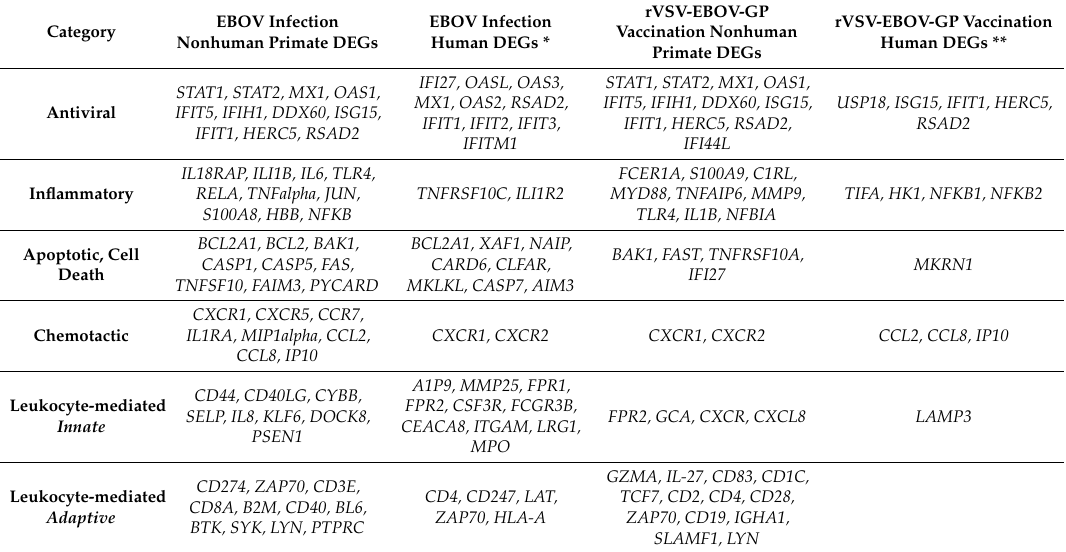
Figure 1. Host response to EBOV infection and rVSV-EBOV-GP vaccination. ( A ) EBOV infection induces a strong, sustained secretion of cytokines and interferon by myeloid cells. Impaired activation of APCs coupled with apoptosis induced by pro inflammatory mediators cumulates in lymphocyte death, preventing the host from mounting an e ff ective adaptive immune response. excessive inflammation, coagulopathy and di ff use organ failure precedes death of the host. ( B ) In contrast, rVSV-EBOV-GP vaccination induces a regulated antiviral interferon response in the absence of the cytokine storm seen in EBOV infection. E ff ective activation and mobilization of antigen presenting cells (APCs) enables a robust. Table 3. Representative di ff erentially expressed genes (DEGs) detected in response to EBOV infection or rVSV-EBOV-GP